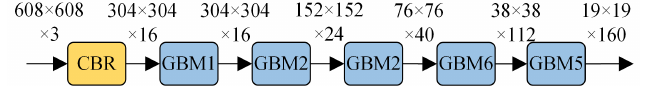
Figure 4. The structure of GhostNet.